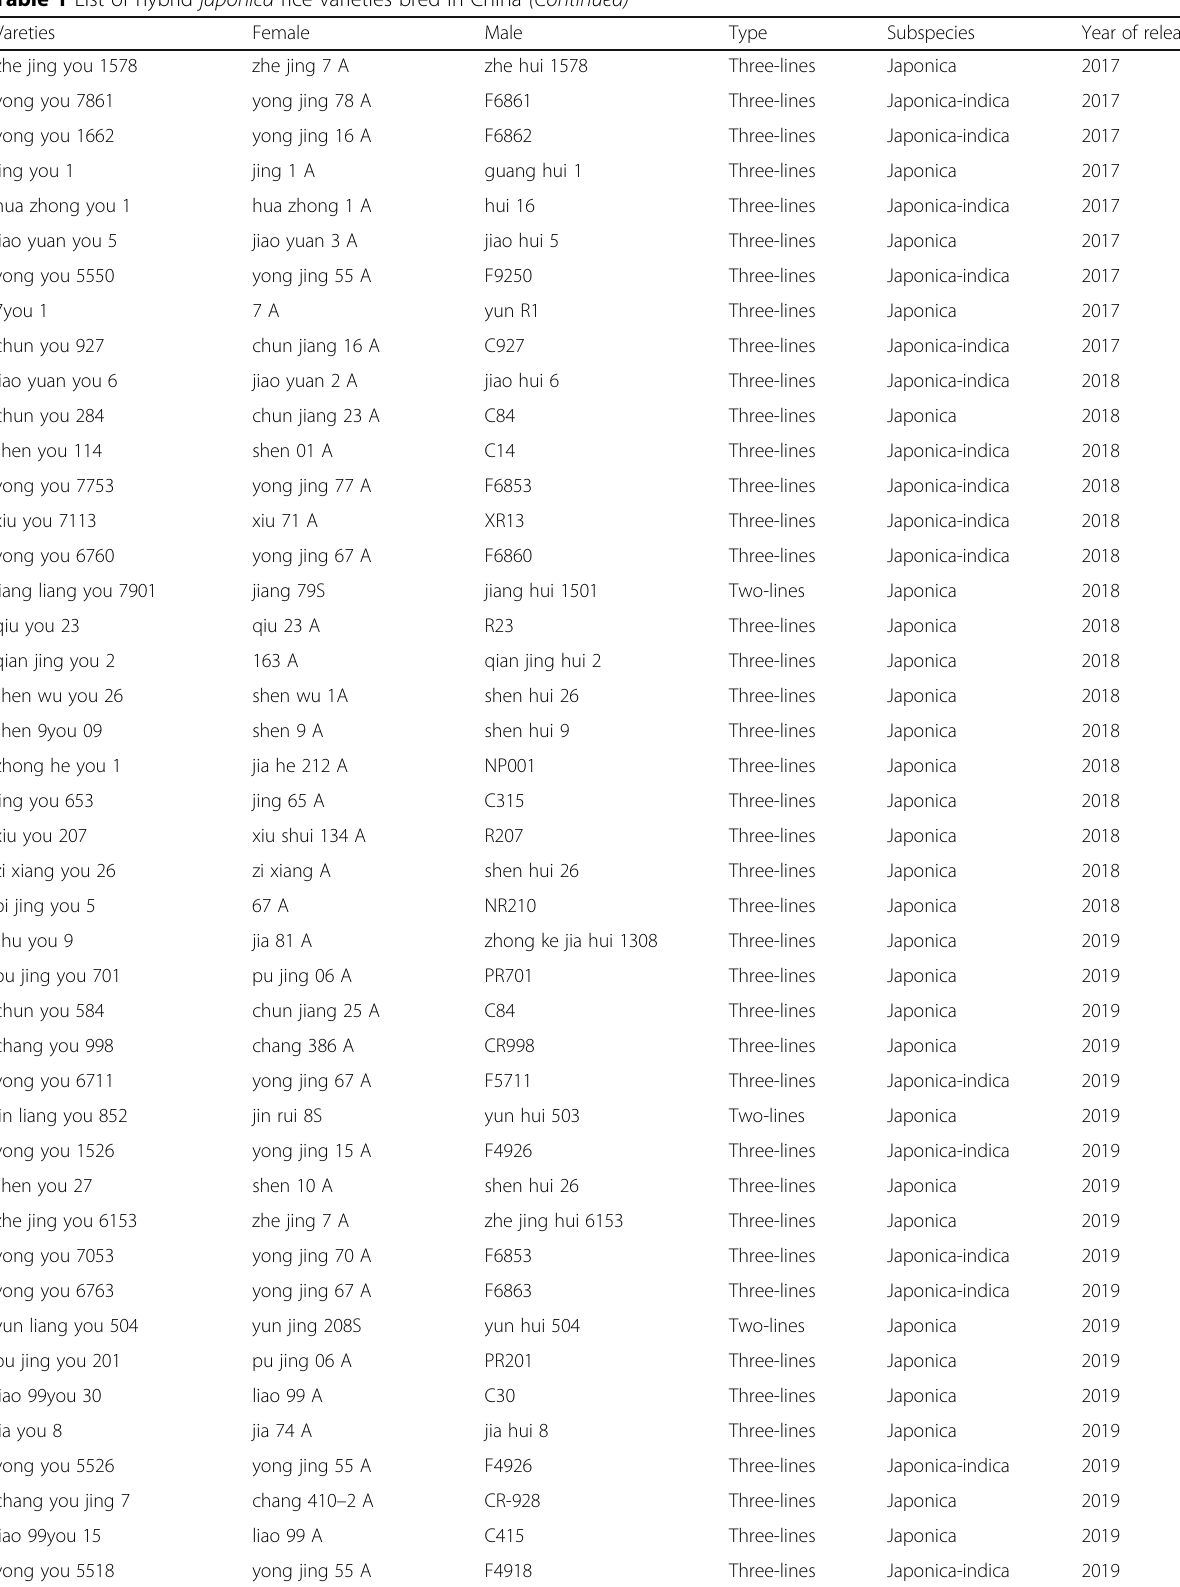
Table 1 List of hybrid japonica rice varieties bred in China (Continued) Vareties Female Male Type